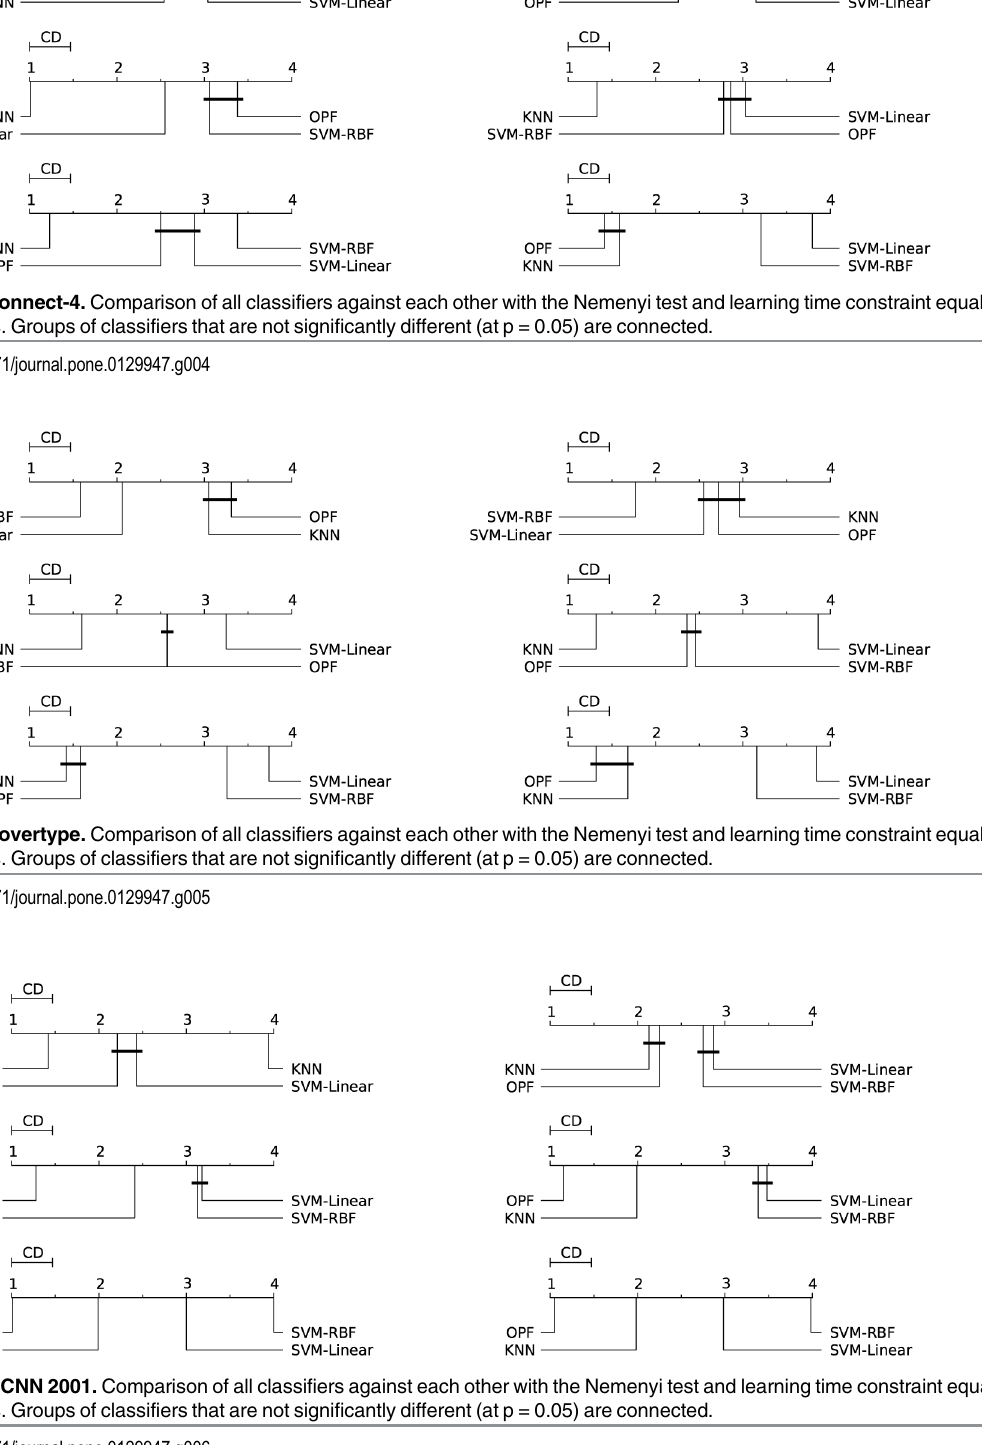
PLOS ONE | DOI:10.1371/journal.pone.0129947 June 26,